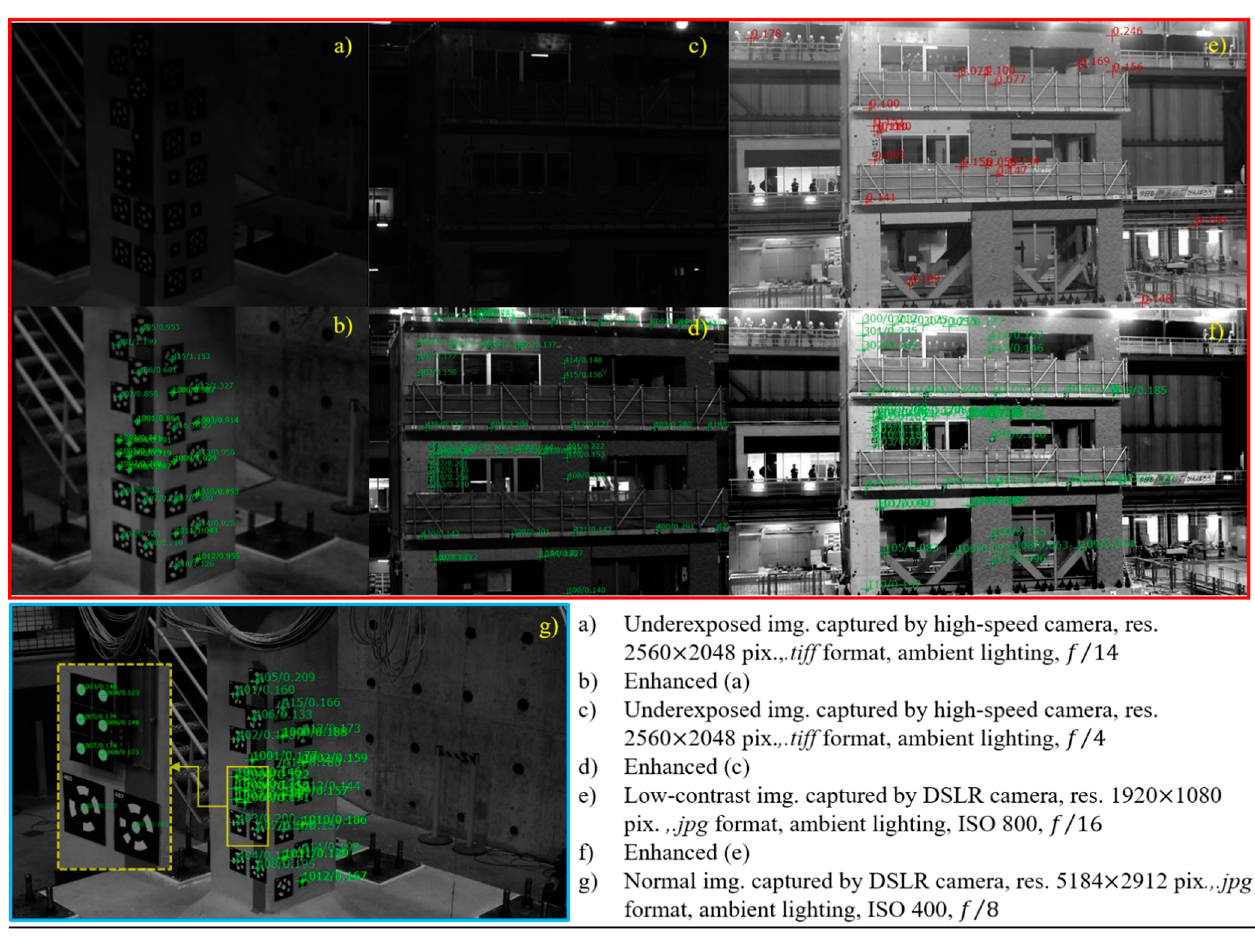
Figure 2. Underexposed and low-contrast images with their associated enhanced versions and identified gray level intensity (green): ( a – d ) images from high-speed cameras, ( e – f ) images from digital cameras, ( g ) normal image from a digital camera with a zoomed view of detected templates and gray level intensity.